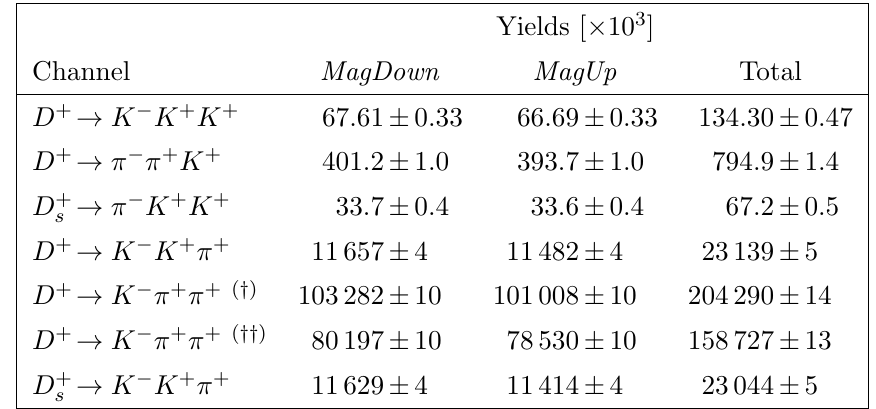
Observed yields for signal and normalisation modes with statistical uncertainties. The entry for the decay D + ! K (cid:0) (cid:25) + (cid:25) +( y ) corresponds to the yields obtained from the (cid:12)t to D + ! K (cid:0) (cid:25) + (cid:25) + sample with cuts optimised for the D + ! K (cid:0) K + K + and D + ! K (cid:0) K + (cid:25) + selec- tions. The entry for the decay D + ! K (cid:0) (cid:25) + (cid:25) +( yy ) is for (cid:12)ts to D + ! K (cid:0) (cid:25) + (cid:25) + samples with cuts optimised for the D + ! (cid:25) (cid:0) (cid:25) + K + selection.